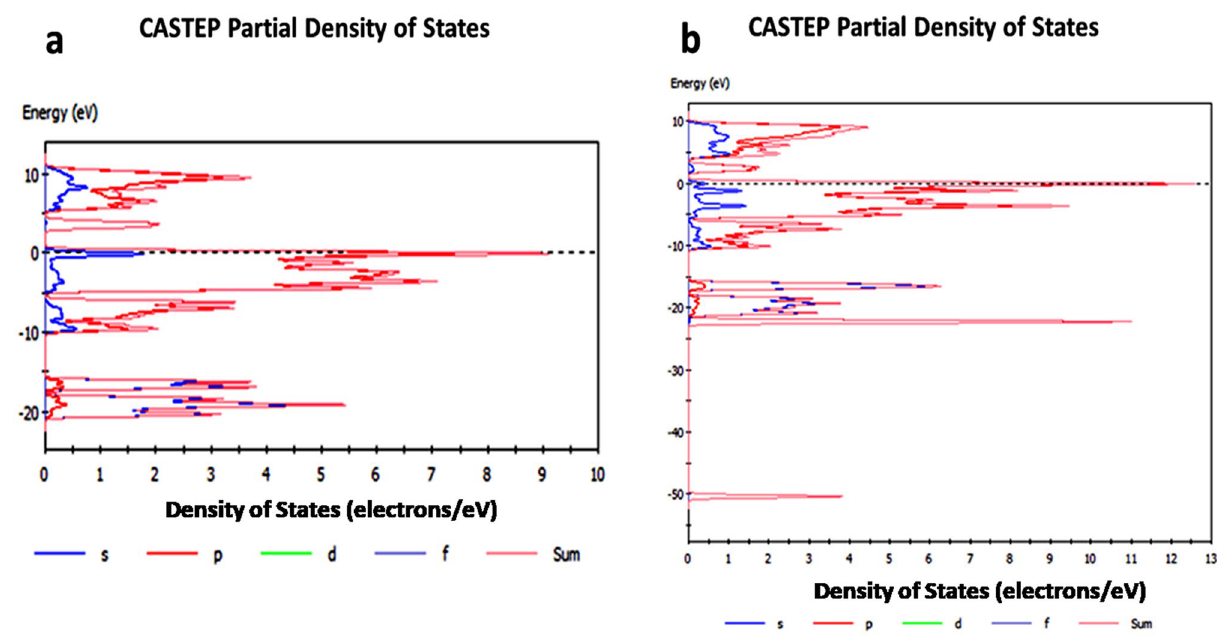
Fig. 10 Projected density of states (PDOS) of a cleaved quartz (001) surface, b NaOH adsorbed on quartz (001)